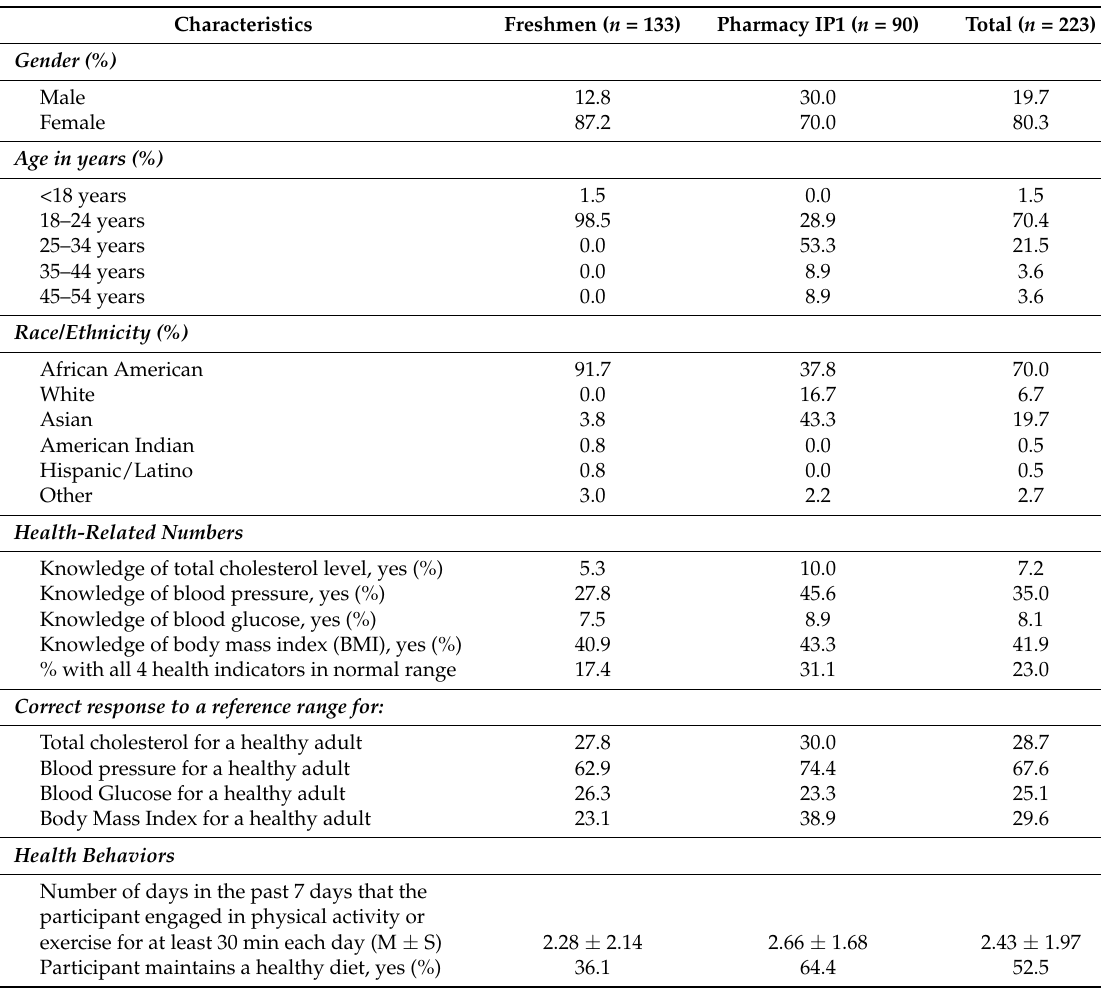
Table 1. Baseline characteristics of